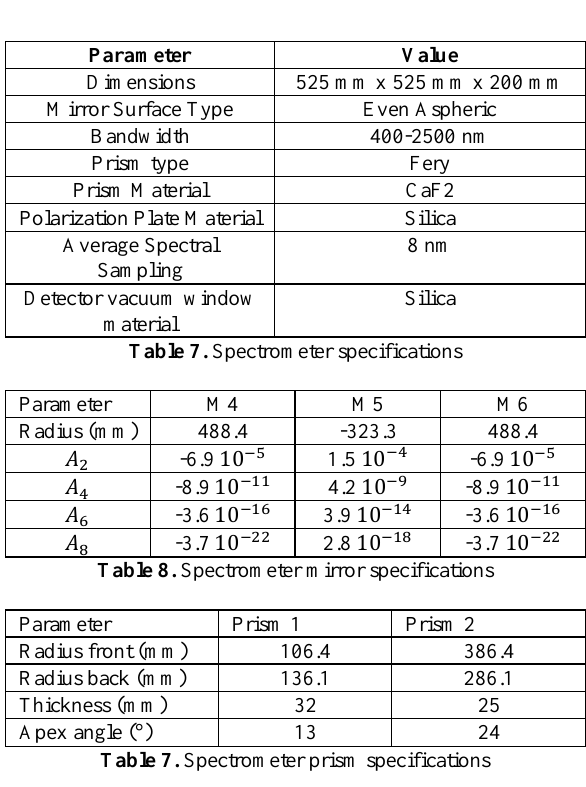
Figure 8. Design layout of the HSI spectrometer